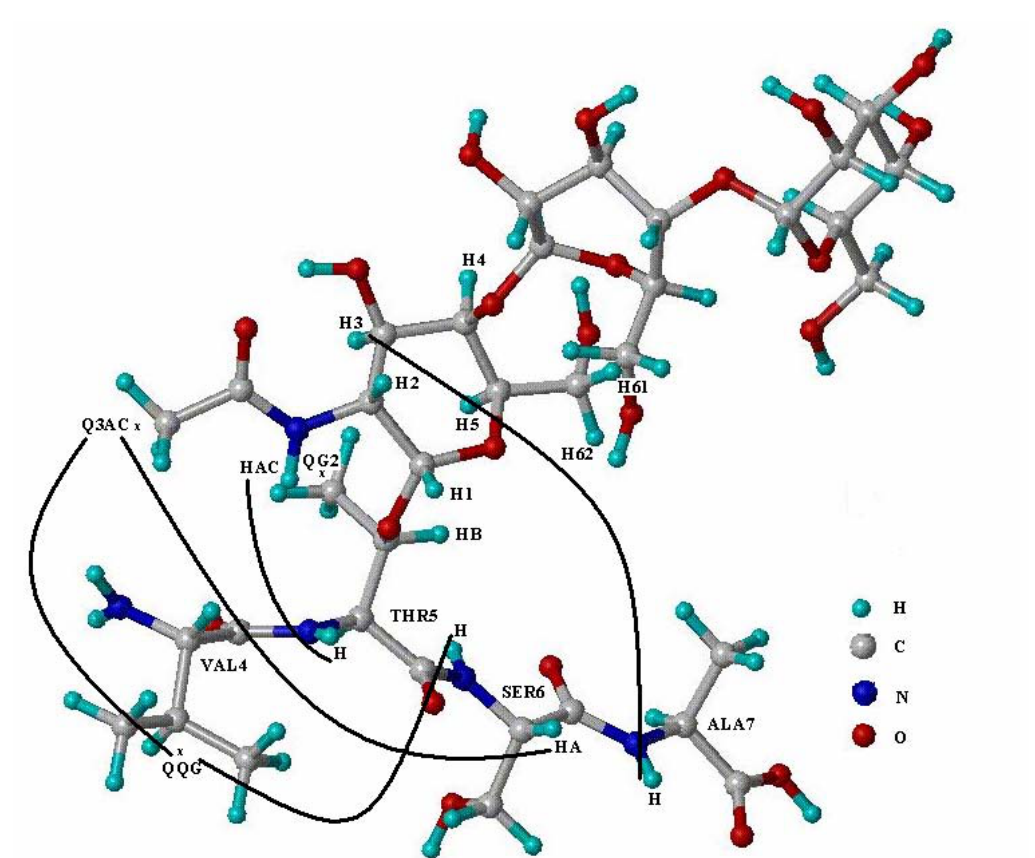
Figure 4. Schematic diagram showing connectivities between protons of α -GalNAc residue in the trisaccharide and protons of the amino acid residues in the peptide segment VTSA (H1, H2, H3, H4, H5, H61, H62 = protons of α -GalNAc residue, Q3AC = methyl group pseudo atom in the N-acetyl group, QQG = pseudo atom at the center of two methyl groups in Val4, QG2 = pseudo atom at the center of the methyl group in Thr5, HAC = amide proton in the N-acetyl group, HA = α proton in the peptide backbone, H = amide proton in the peptide